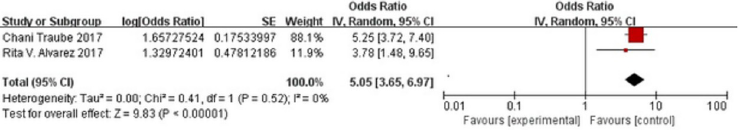
Fig 4. Forest plot for benzodiazepine use analysis. We conducted meta-analysis for 2 studies using a random effects model. We used ORs and 95% CIs to represent the results.